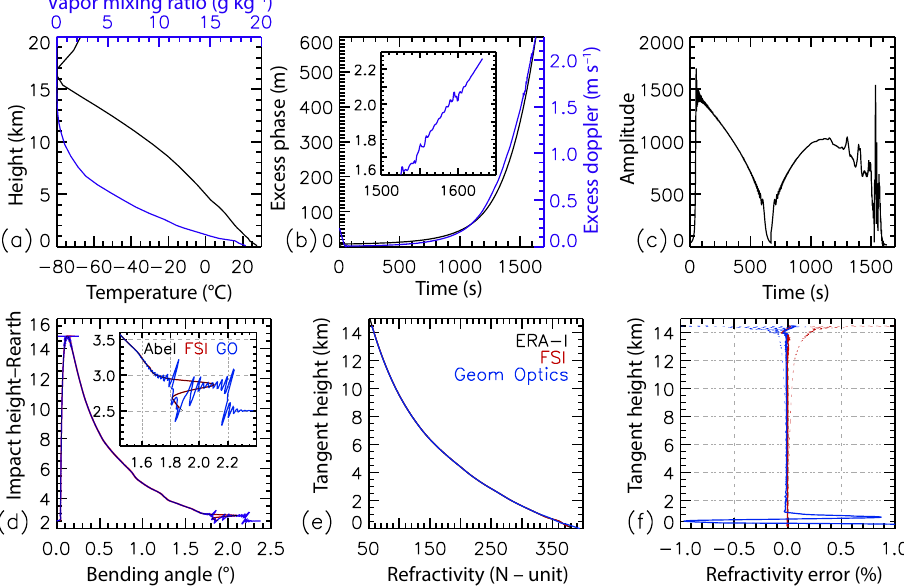
Figure 3. (a) ERA-I temperature and water vapor mixing ratio at 18:00UTC on 13 September 2010 at 16.5 ◦ N, 76.5 ◦ W; (b) simulated excess phase and derived Doppler velocity (inset shows the Doppler velocity after 1500s); (c) simulated signal amplitude; (d) bending angles retrieved using GO and FSI, and simulated bending observation with ERA-I refractivity profile (inset shows the close-up of the profile near the surface); (e) refractivity profiles from GO, FSI retrievals and the ERA-I; (f) fractional refractivity error of GO (blue), and FSI (red) compared to ERA-I. Dashed and solid lines are respectively for refractivity retrievals before and after the simple exponential atmospheric model near the receiver is